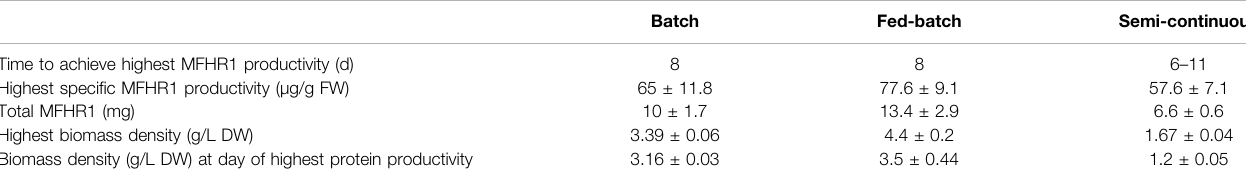
TABLE 2 | Recombinant protein (MFHR1) productivity in several operation modes in moss bioreactors.